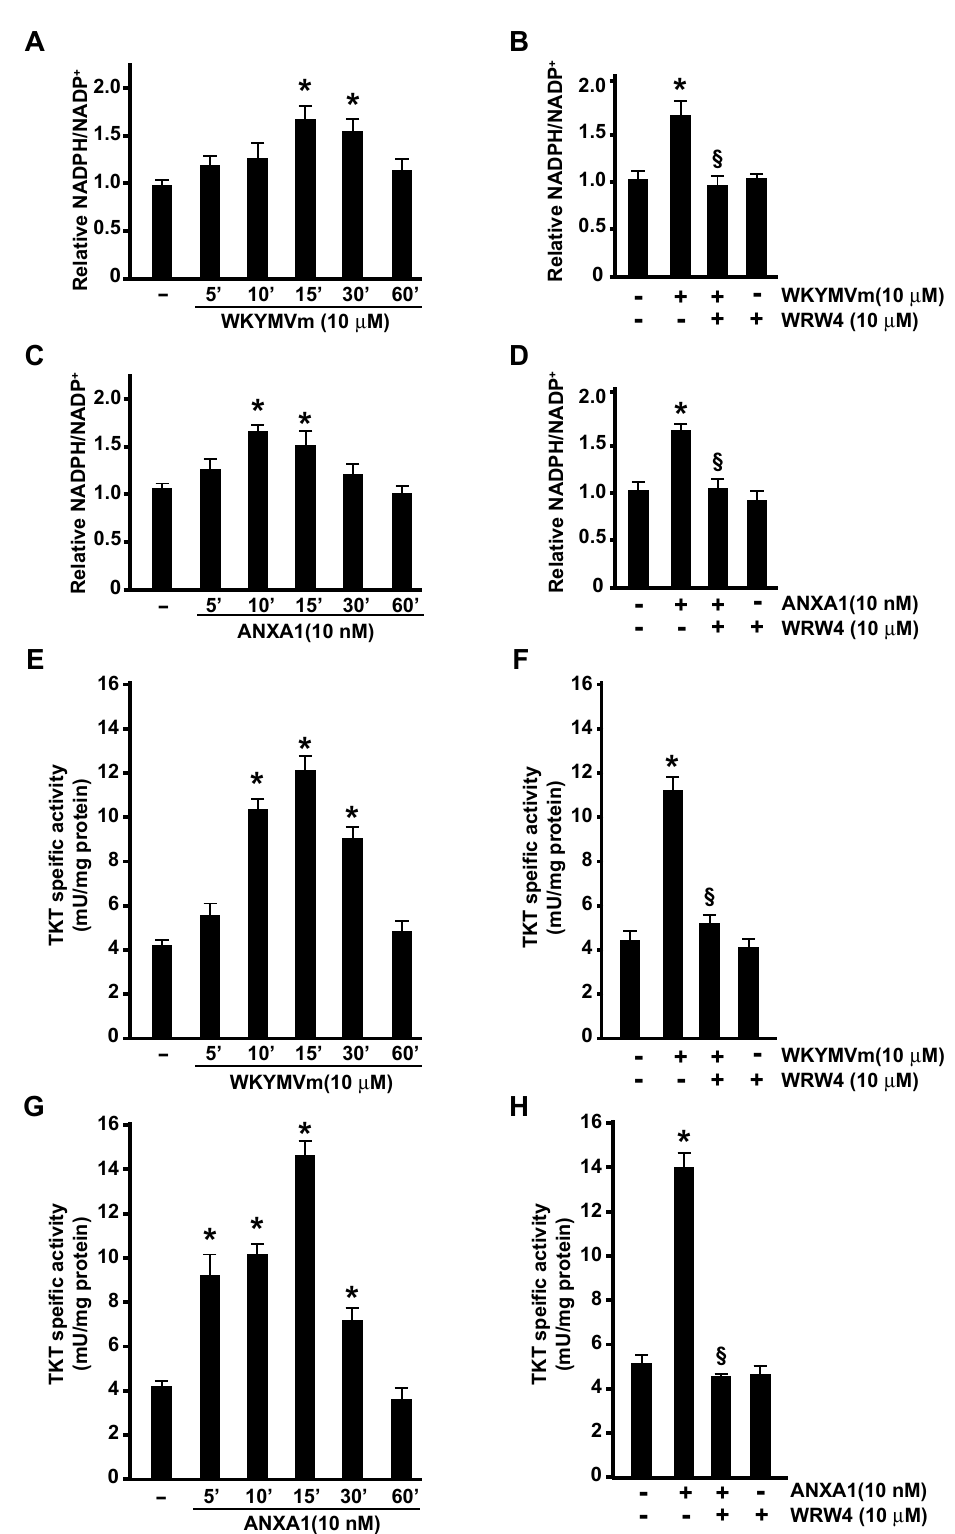
Figure 2. FPR2 stimulation enhances NADPH production and regulates non-oxidative phase of pentose phosphate pathway. CaLu-6 cells were serum-starved for 24 h and then stimulated with WKYMVm (Panels ( A , E )) or ANXA1 (Panels ( C , G )) for the indicated times. Cells were also preincubated with WRW4 before WKYMVm (Panels ( B , F )) or ANXA1 (Panels ( D , H )) stimulation. NADPH/NADP+ assay was performed according to manufacturer’s instruction (Panels ( A – D